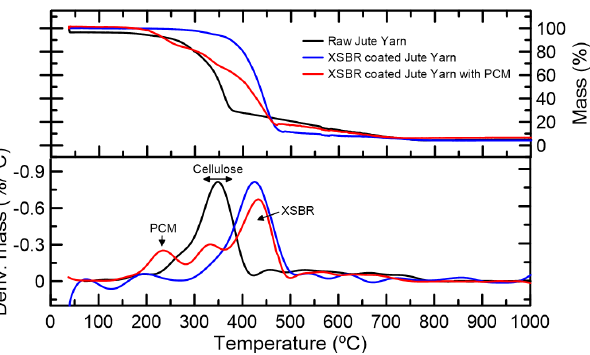
Figure 12. Thermogravimetric analysis curves: TG and DTG of raw and treated jute yarns.